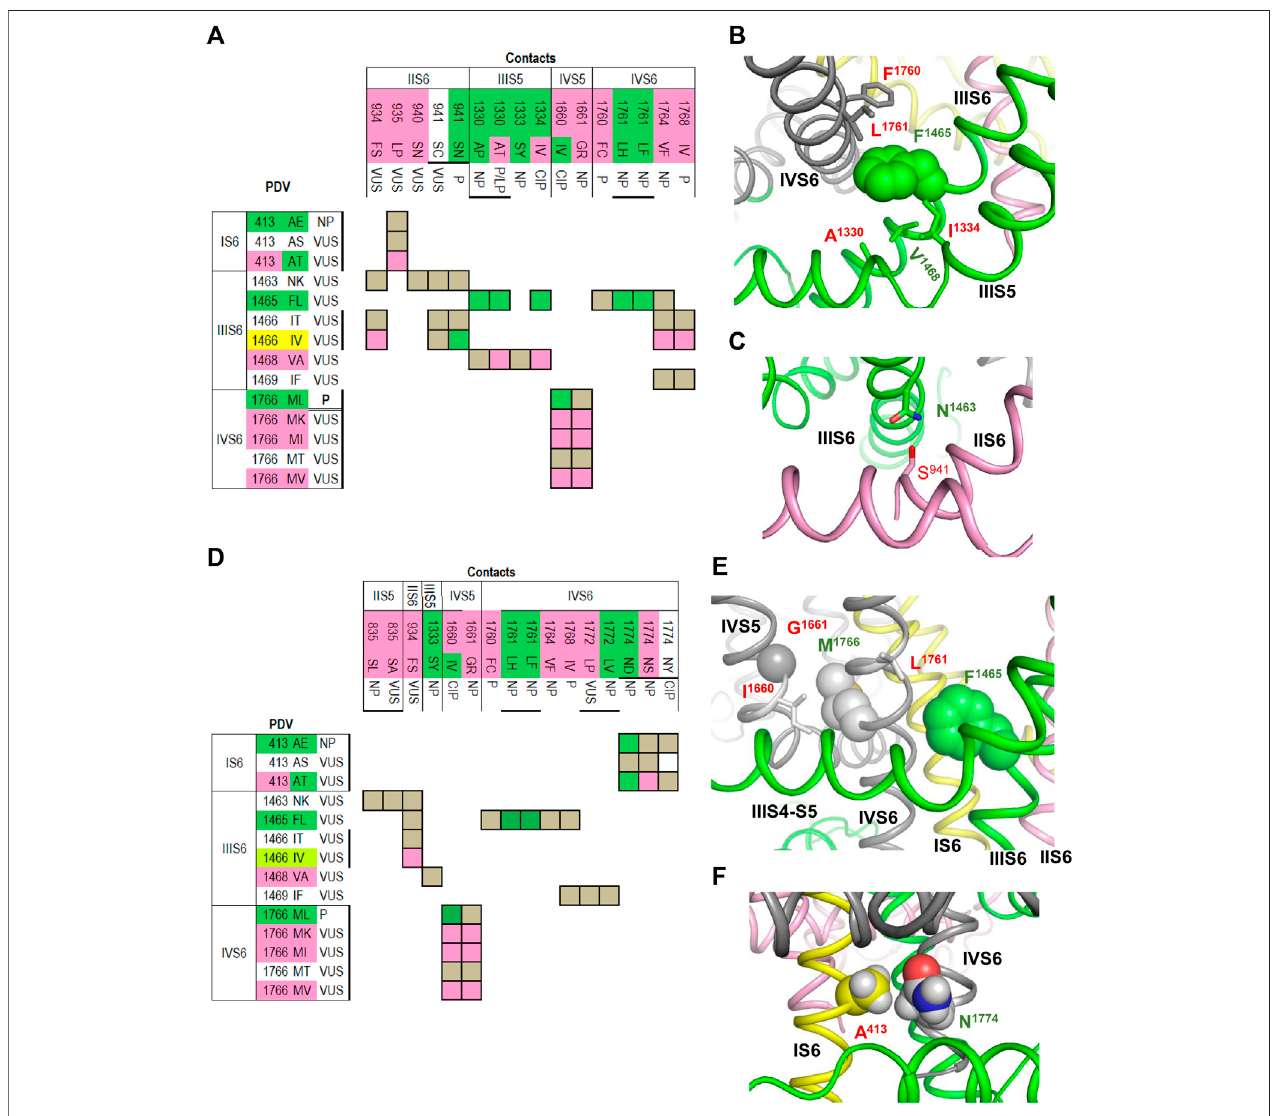
FIGURE 4 | Open and closed conformations of PD. (A – C) Open PD model. (A) Matrix of contact variants shows only those PDVs and their contacts, which are unique in the open PD model. Most of coupled variants are associated with either BrS1 or LQT3. ( B) Hydrophobic contacts L 1761 :F 1465 :F 1760 and A 1330 :V 1468 :I 1334 stabilize, respectively, mutual disposition of helices IIIS6/IVS6 and IIIS5/IIIS6. (C) H-bond S 941 :N 1463 stabilizes mutual disposition of helices IIS6/IIIS6. (D – F) Closed PD model. (D) MatrixofcontactvariantsshowsonlythosePDVandtheircontacts,whichareuniqueintheclosed-PDmodel. (E) MutualdispositionofhelicesIIIS6and IVS6 in the closed PD is stabilized by hydrophobic contacts F 1465 :L 1761 with side chain conformations different from those in the open-PD model. In coupled LQT3- associated variants, substitutions F 1465 L or L 1761 F/H would destabilize the closed PD. Mutual disposition of helices IVS5/IVS6 is stabilized by a hydrophobic contact M 1761 :I 1660 andaknob-into-holecontactM 1761 :G 1661 . (F) MutualdispositionofhelicesIS6/IVS6isstabilizedbyatighthydrophobiccontactbetweenA 413 andmethylene group of N 1774 . Replacement of any contact partner with a large residue would destabilize the closed PD, a likely cause of LQT3 associated with these mutations.